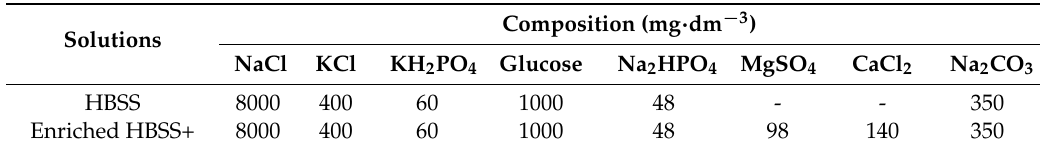
Table 1. Chemical composition of HBSS and enriched HBSS+ used in